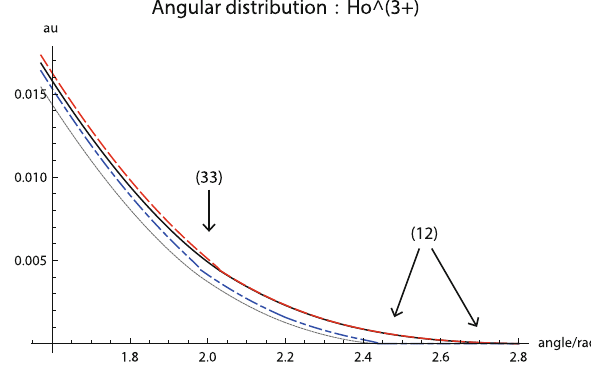
Fig. 6 RANP angular distribution with r = − 0 . 36532 of trivalent Ho. Cases of NO Majorana of smallest neutrino mass 1 meV in solid black, NOMajoranaof50meVindottedblack,NODirac1meVindashedred, and NO Dirac 50 meV in dash-dotted blue. The absolute rate is obtained bymultiplyingafactor5 . 1 × 10 − 6 s − 1 assuming n 3 V η = ( 10 17 ) 3 cm − 6 . This rate unit is applied to Figs. 5, 7 and 8 as well